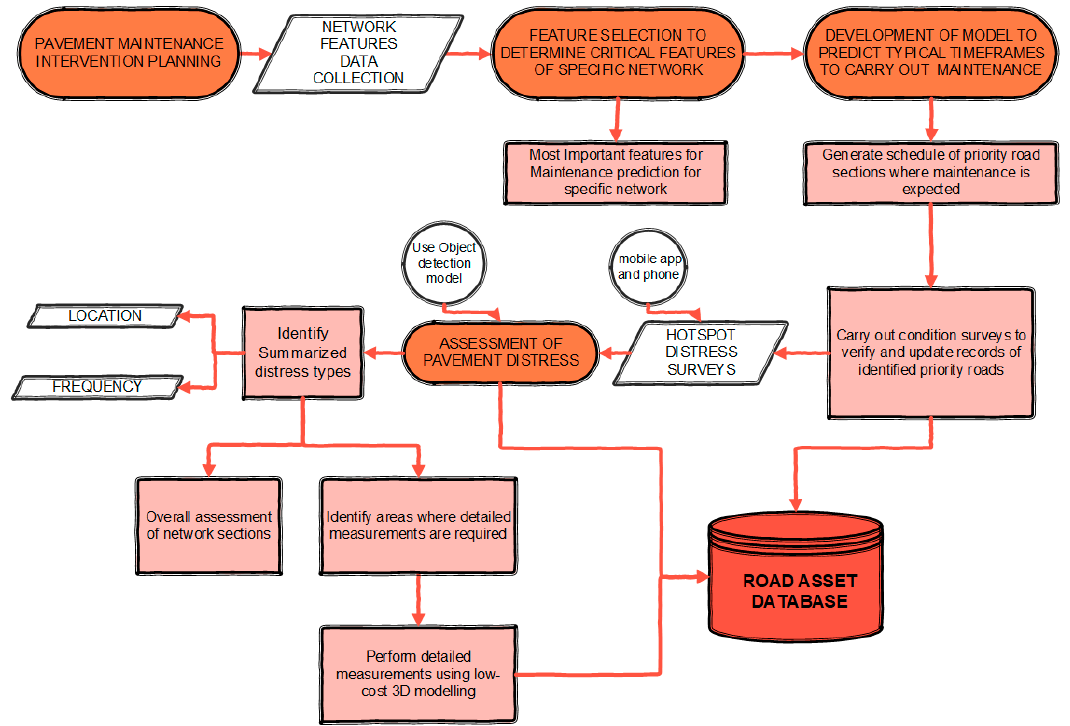
Figure 18. Workflow for the practical implementation of the methodology.